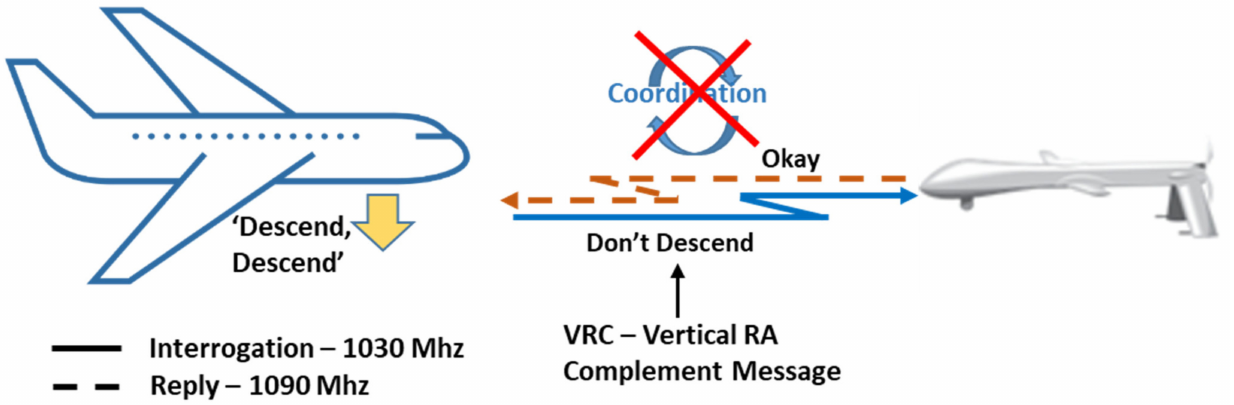
Figure 12. Interoperability with TCAS-II